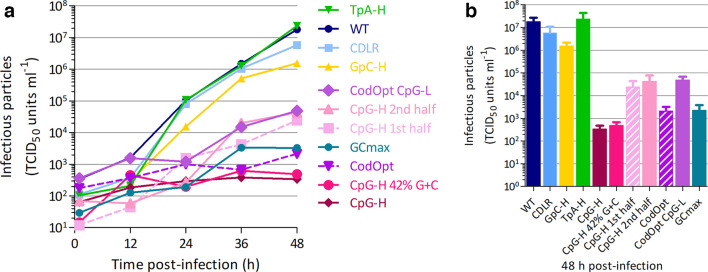
Effects of V2 sequence modifications on MVM replication kinetics. (a) Multi-step growth curve in the A9 cell line infected with 1 TCID50 unit/cell. Supernatant was harvested at different time points and titred in NB324K cells. Data points represent the mean of three biological replicates. (b) Cross-section of the growth curve at 48 h. Bar heights represent the mean of three biological replicates; error bar show sems.